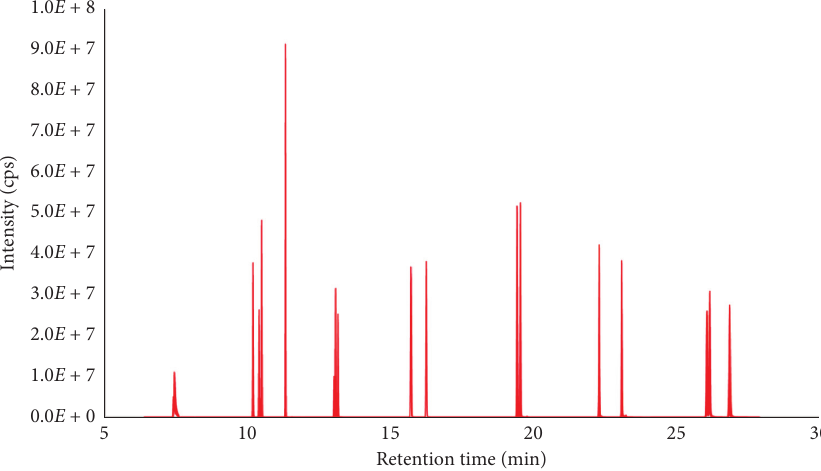
Figure 2: Total ion chromatogram of PAHs on Thermo TG 5ms column. Table 1: Retention times, MS/MS transitions, and collision energy of 16 PAHs and isotopic labelled internal standards in MS/MS